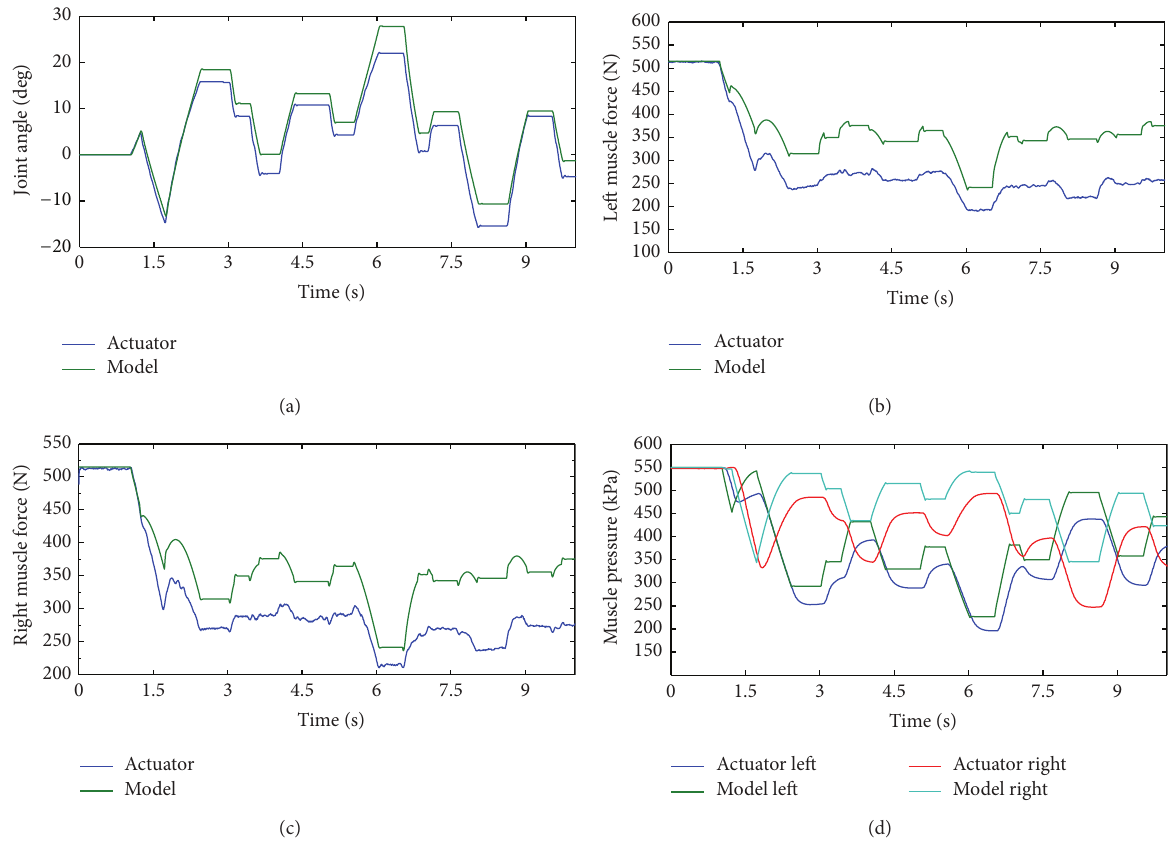
Figure 9: Comparison of model and actuator performance for the excitation signal shown in Figure 8 with nominal moment of inertia ((a) joint angle response, (b) left muscle force response, (c) right muscle force response, and (d) muscle pressure response for both